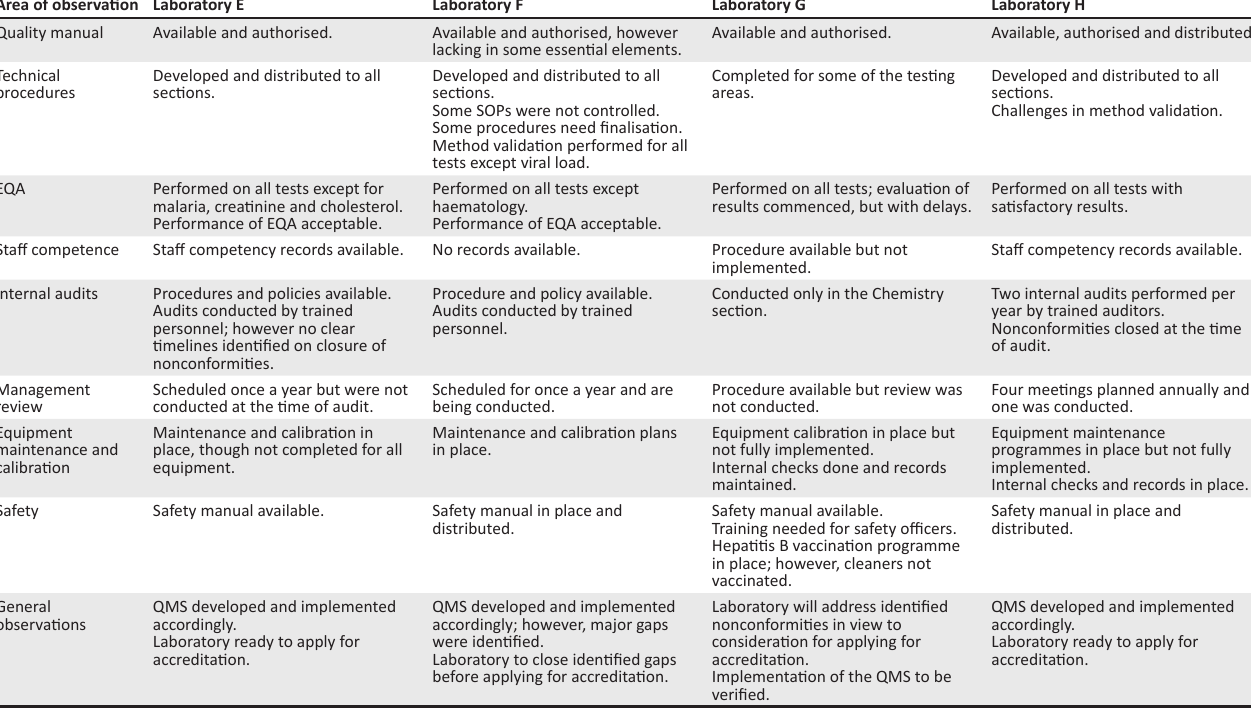
TABLE 2: Qualitative results from trial assessment using the SANAS checklist in BOBS-mentored laboratories enrolled in the Botswana SLMTA programme 2010−2011. Area of observation Laboratory